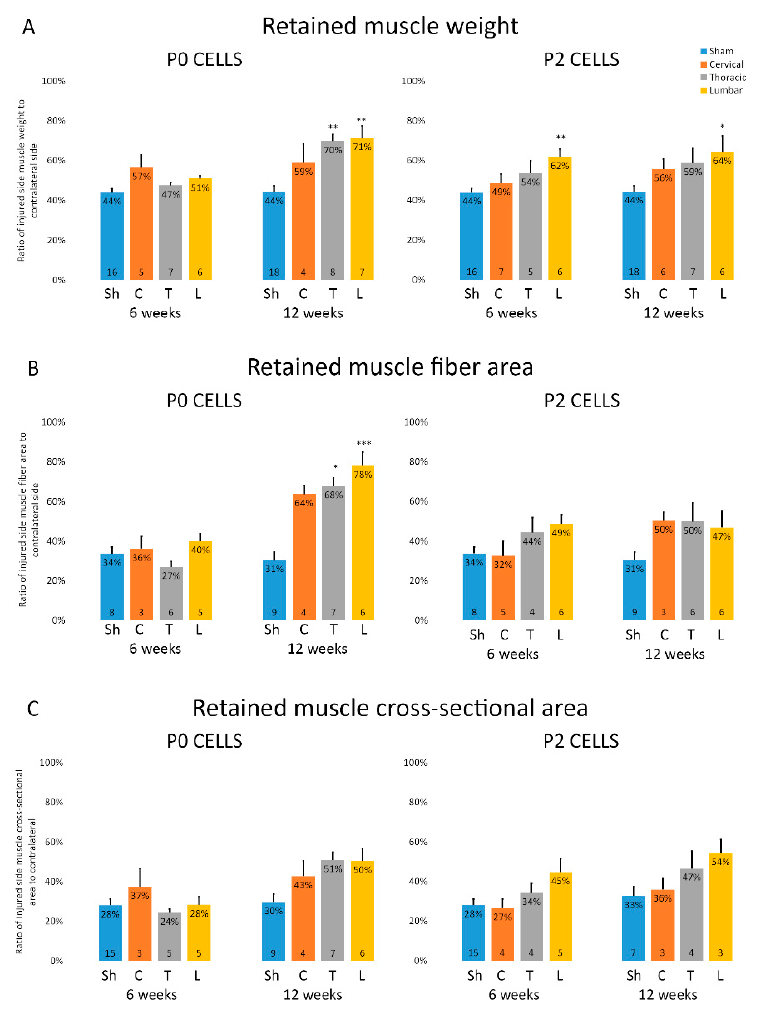
Figure 4. Cells isolated from different embryonic spinal cord segments show differential reduction of muscular atrophy. Sh—sham control, C—cervical cells, T—thoracic cells, L—lumbar cells. ( A ) Analysis of muscle weight ( B ) Analysis of muscle fiber area; ( C ) Analysis of muscle cross-sectional. Data is expressed as mean + SEM. Statistical difference is shown versus Sham. * p < 0.05, ** p < 0.01, *** p < 0.001. The number of animals in each group is shown inside the bar base.